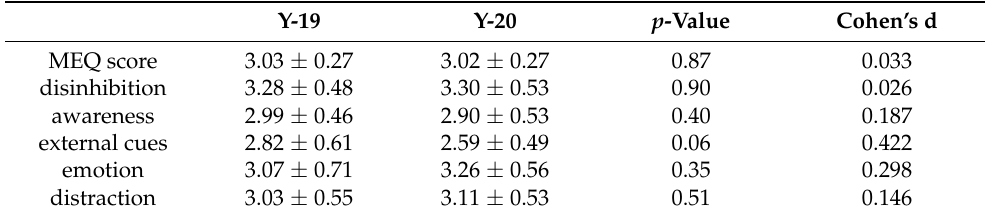
Table 4. MEQ and subscale scores for educators working in ECEC-licensed centers before and during the COVID-19